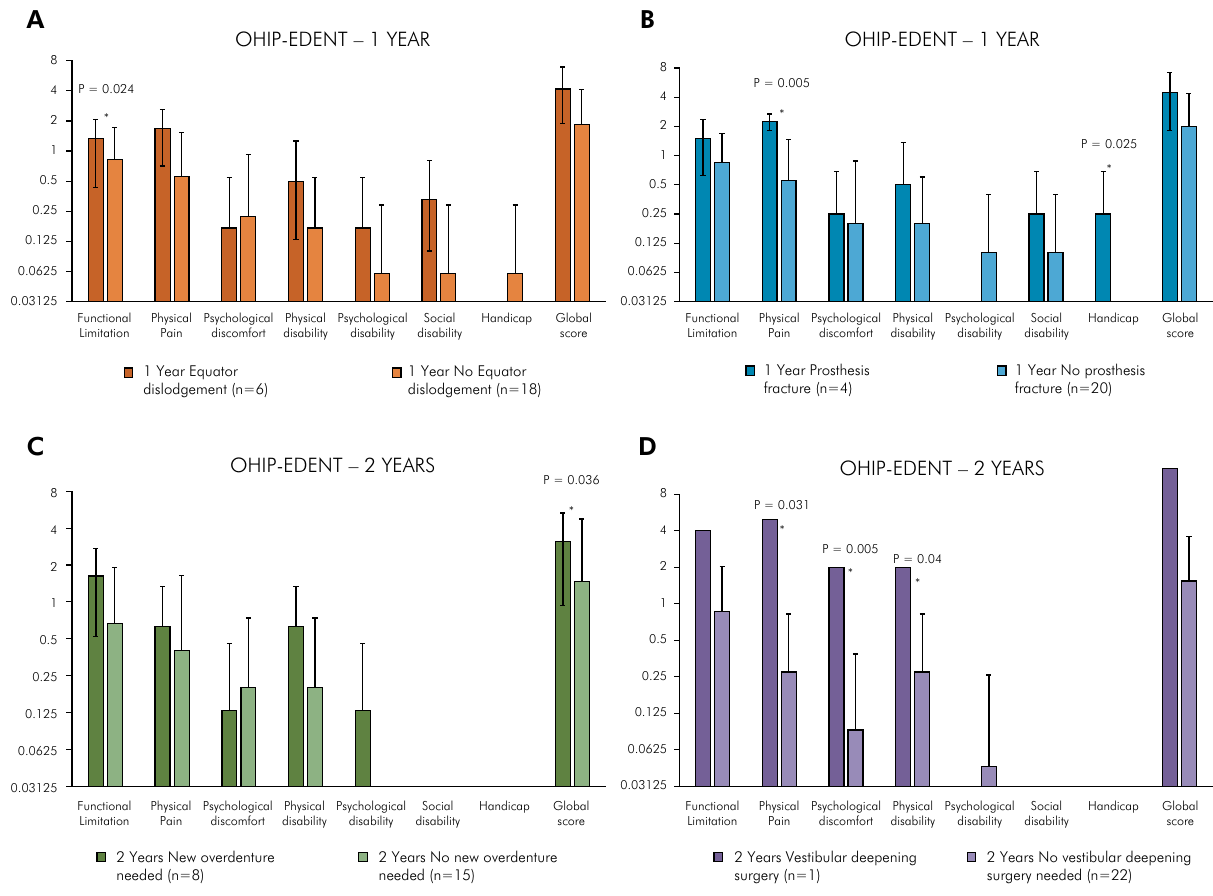
Figure 3. Influence of prosthetic events on the OHIP-EDENT questionnaire domains that had statically significant differences in the Mann-Whitney test (p < 0.05): One Year: a) Equator dislodgement influenced the Physical Pain domain; b) Prosthesis fracture influenced the Handicap and Physical Pain domains. Two Years: c) New overdenture confection influenced the global score; d) Vestibular deepening surgery influenced the Physical Pain, Psychological Discomfort, and Physical Disability